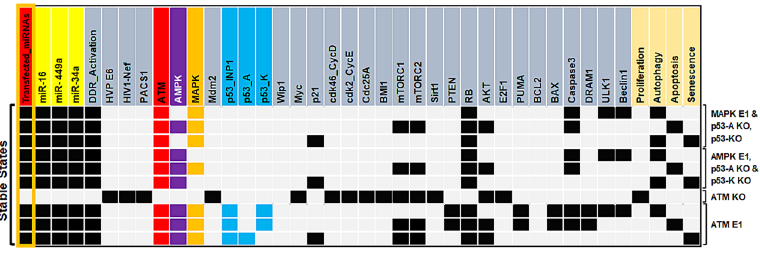
Figure 6. The p53-independent signaling pathways. Gain of function (GoF) determines overexpression (E1) while loss of function (LoF) describes the knockout (KO) of the component corresponding to the model. The stable states were characterized for several scenarios: MAPK E1, AMPK E1 along with p53 KO, ATM KO, and ATM E1. White cells indicate a zero value, while black/red/purple/orange and blue cells indicate activation (value 1). The left-hand side highlighted in orange box presents the status of the input transfected miRNAs and the right-hand side shows the outputs of the model such as proliferation, autophagy, apoptosis, and senescence. Per line describes a single stable state or fixed point analogous to the input. The first three steady states or fixed points belong to the gain-of-function (GoF) of MAPK as well as loss-of-function (LoF) of p53 and the next three steady states describe the gain-of-function (GoF) of AMPK along with the loss-of-function (LoF) of p53: defines alternative signaling pathways in the G1/S arrest. The knockout (KO) of ATM inhibits arrest. Whereas, the gain-of-function (GoF) of ATM suppresses proliferation and induces the identified arresting phenotypes such as autophagy, apoptosis, and